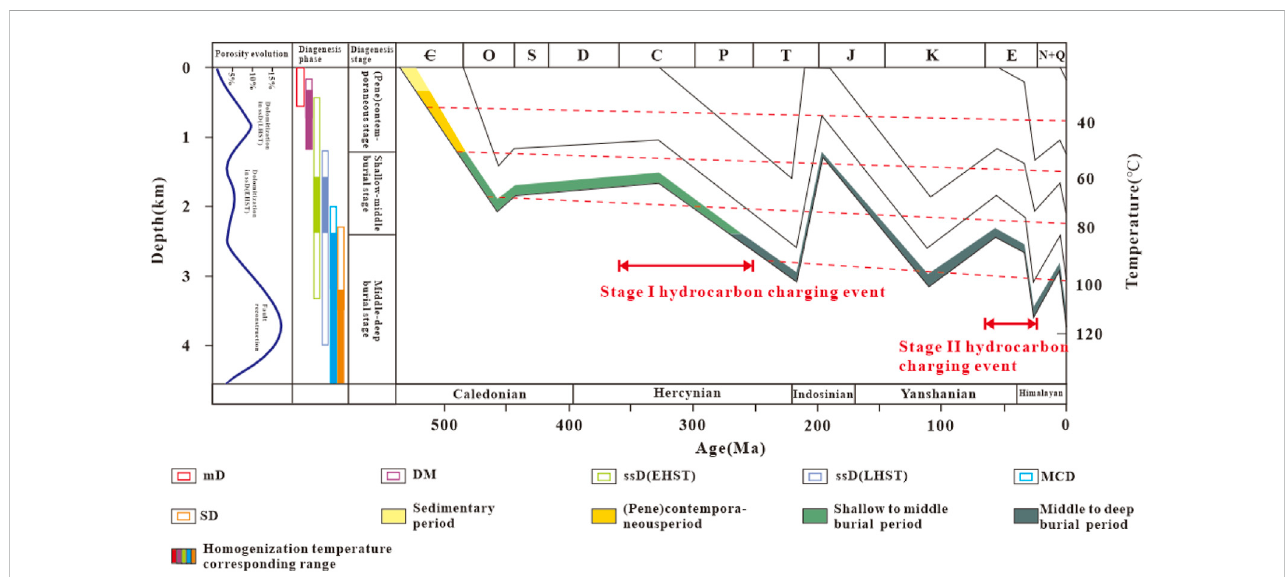
FIGURE 11 Burial and diagenetic evolution history in the upper changping formation, Dingjiatan area, North China platform.